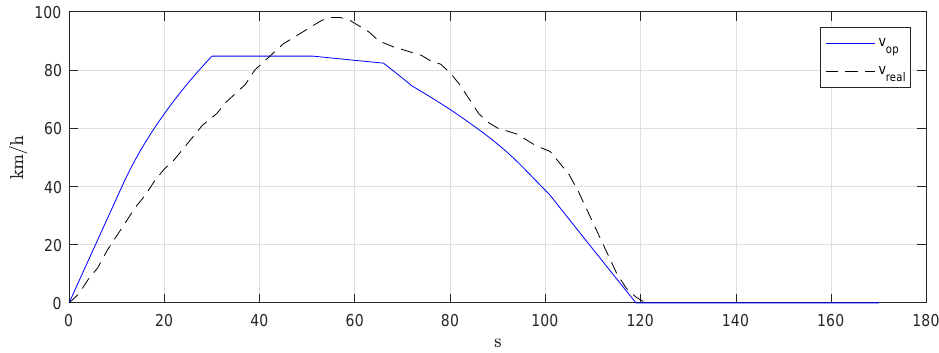
Figure 12. Case B—Actual (dashed black) and proposed (solid blue) speed profiles.